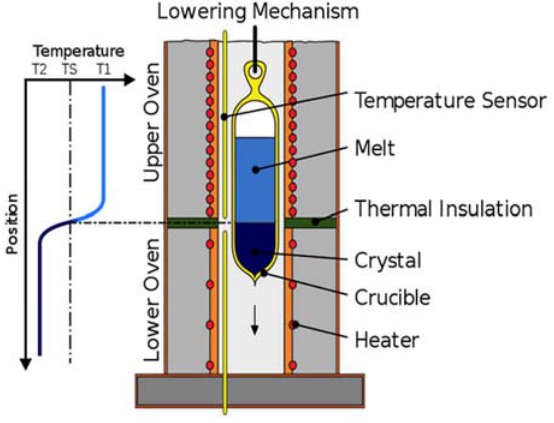
Figure 8. Schematic of the Bridgman–Stockbarger method [77].